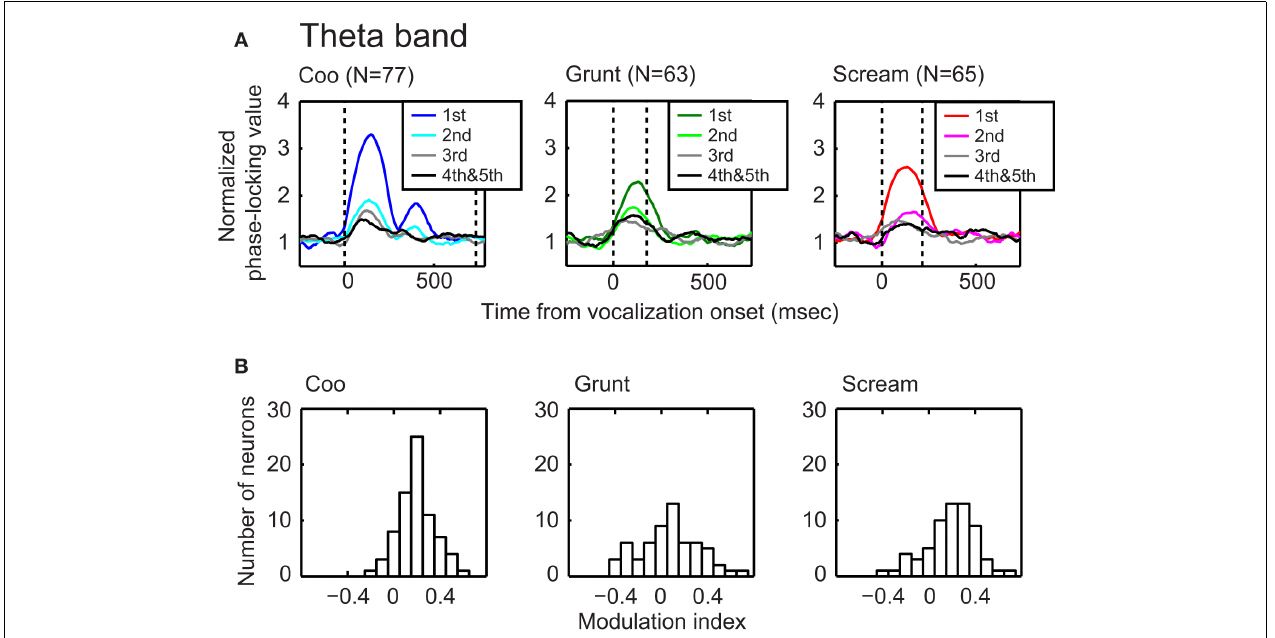
aligned relative to vocalization onset (i.e., the vertical dotted line at time t = 0). The second dotted line indicates vocalization offset.The data in (B) show the distributions of modulation-index values as a function of vocalization: coo (left; n = 77 sites), grunt (middle; n = 63 sites), and scream (right; n = 65 sites).The mean value of each distribution is reliably ( t -test; p < 0.05) greater than zero, indicating that, for each vocalization, the phase-locking of the theta band reliably decreased with stimulus